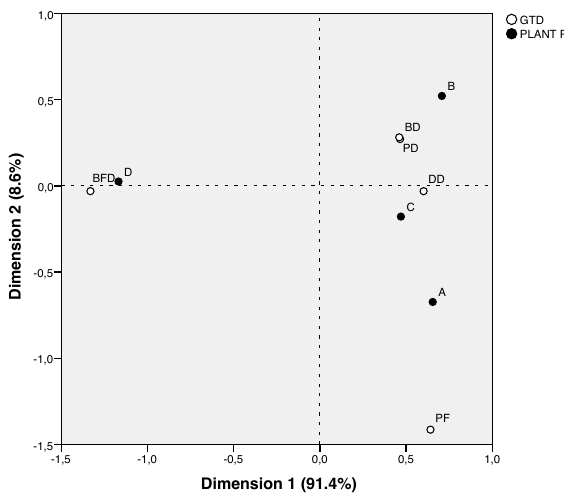
Figure 1. Correspondence analysis biplot between GTDs and the three nurseries. BFD = Black foot disease, BD = Bot- ryosphaeria dieback, PD = Petri disease, DD = Diaporthe dieback, and PF = Pestalotioid